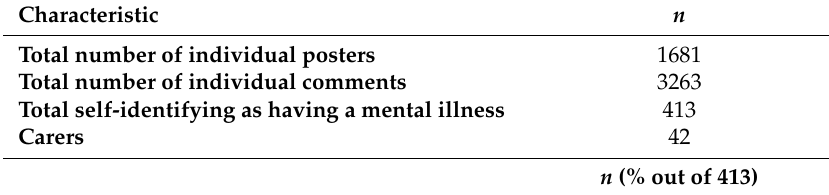
Table 1. Characteristics of posters contributing to Reddit posts included in the analysis.